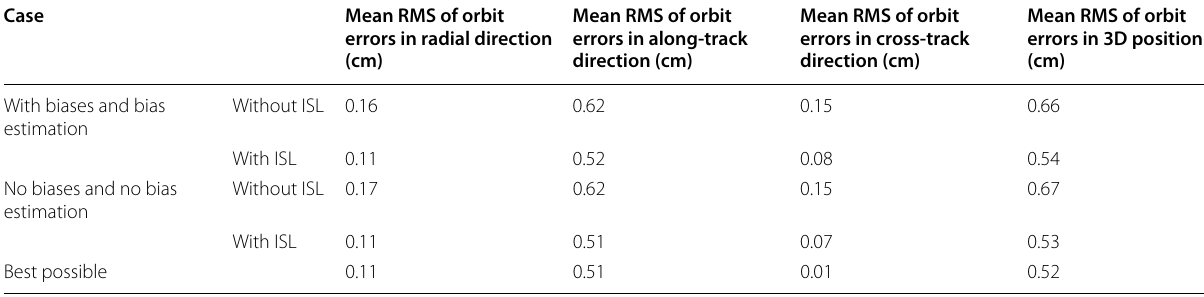
Table 4 Mean RMS of orbit errors in radial, along-track, cross-track and 3D position directions, global network